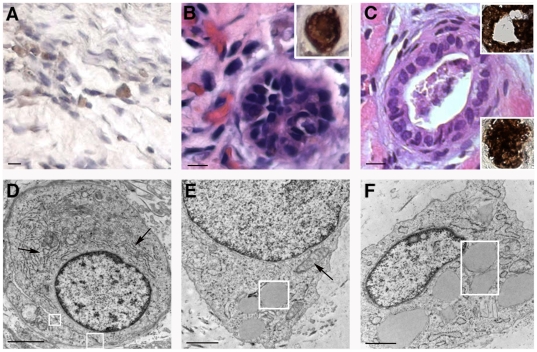
Morphology of gels containing passage 1 HFH implanted at an ectopic site.A: H&E-stained section from a graft harvested at 2 weeks post-engraftment showed the presence of RBC-filled capillaries and a duct-like structure lined with columnar epithelial cells that stain intensely positive for CK8/18 (inset). B. At 4 weeks post-engraftment, a small proportion of the unorganized extra-vascular cells within the HFH gel stroma stained positive for CK8/18. Staining was absent in similarly-stained Bcl-2-HUVEC alone gels. C: H&E-stained sections from a graft harvested at 4 weeks post-engraftment showed a duct with a lumen that stains intensely for CK8/18 (top inset) and CK7 (bottom inset). D, E: TEM analyses identified metabolically active HFH possessing extensive rough endoplasmic reticulum (D, arrows), tight junctions (D, box) with an immature intervening canalicular region, phenotypically normal mitochondria (E, arrow), and lipid droplets (E, box). F: Quiescent stellate cells harboring numerous large fat droplets (box) were also observed. Size bars: 10 µm (A-C), 2 µm (D, E), and 1 µm (F).